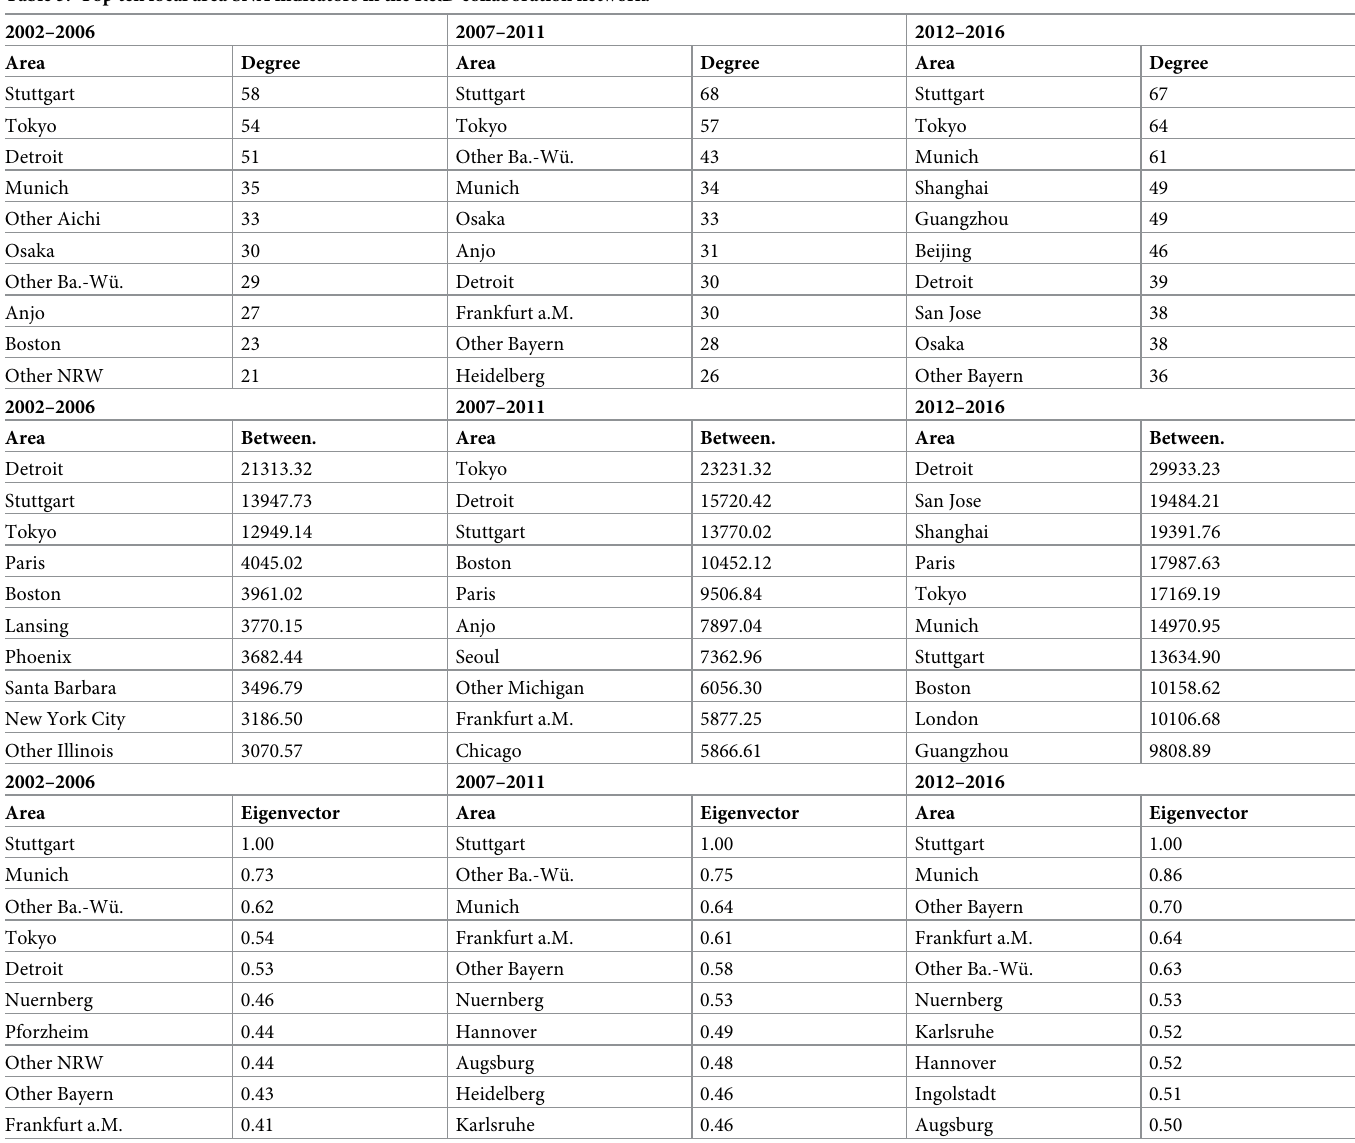
Table 3. Top ten local area SNA indicators in the R&D collaboration